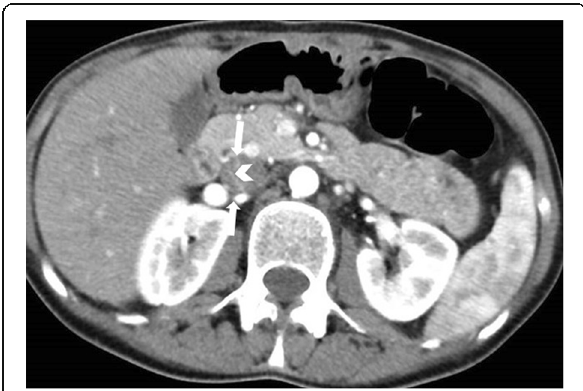
Fig. 24 A 21-year-old female patient with recently diagnosed (with genetic testing after a recent diagnosis of her elder sister) VHL underwent a baseline CT exam. Axial plane post-contrast pancreatic phase CT image shows a predominantly cystic lesion in the uncinate process (arrows) with enhancing mildly thickened internal septation (arrowhead). The lesion was found to be highly suspicious of a cystic